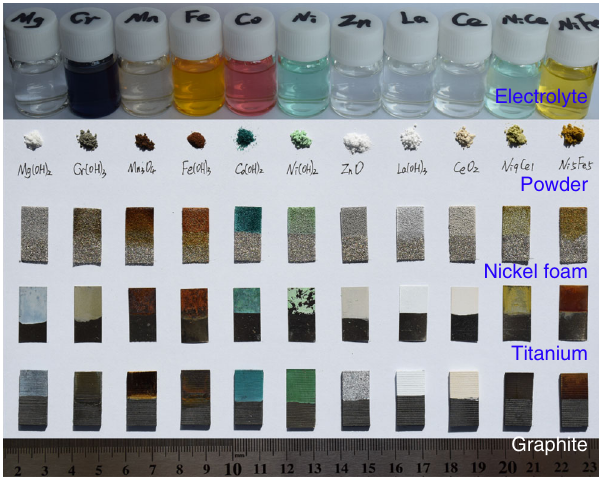
Fig. 2 Universality of the cathodic electrodeposition. Optical photographs of the electrolyte precursors, the corresponding generated samples on different substrates, and the collected powders from Ti foil. Each electrodeposition was performed by applying a constant current density of − 20 mA cm − 2 for 300 s in 0.1 M metal nitrate